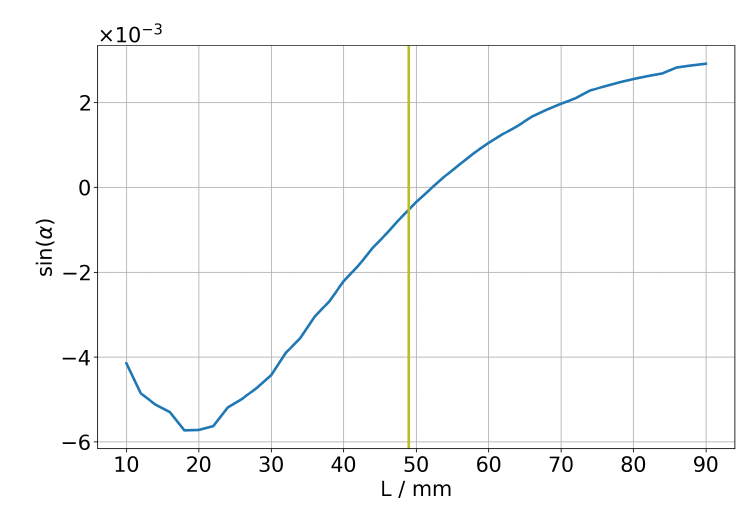
Figure 4. Ratio of the radial to the total magnetic field sin ( α ) = B r / B averaged over analytical sampling points within the box area ( r ≤ 0.1 ⋅ R , z ≤ 0.1 ⋅ L ,) for various configurations L and fixed radius R = 20mm. The olive vertical line denotes the analytical solution, where the field lines are particularly